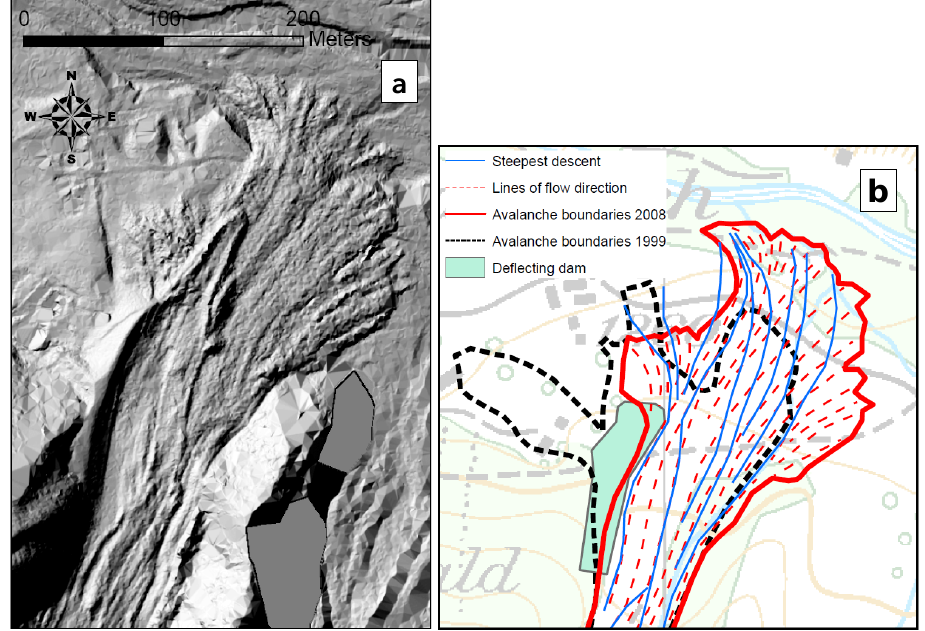
Fig. 9. Panel (a) shows hillshade of the lower deposition zone of the Gatschiefer avalanche from laser scanning measurements. The flow direction is highlighted by the presence of numerous levees. Panel (b) shows a comparison between flow lines (dashed red lines) and the direction of the steepest descent (blue lines). The boundaries of the 1999 and 2008 avalanches are also